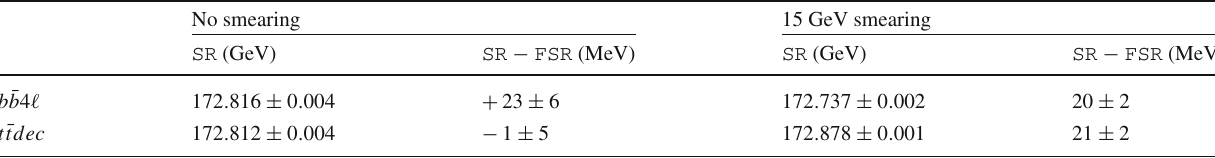
Table 5 m Wb peak position for m t =172.5 GeV obtained with the b ¯ b 4 (cid:4) and t ¯ tdec generators, showered with Pythia8.2 , for the j ScaleResonance ( SR ) veto procedure. The differences with FSREmission ( FSR ), that is our default, are also